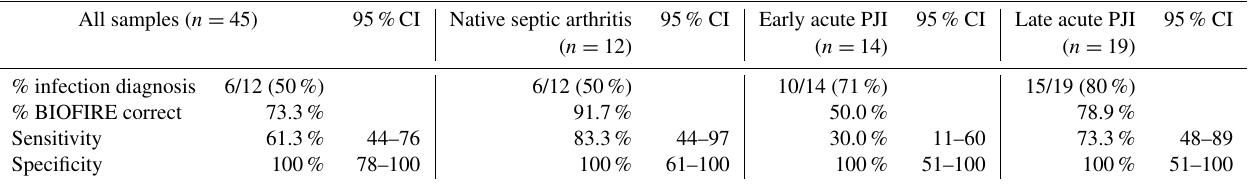
Table 3. Test accuracy of the BIOFIRE JI Panel for infection according to criteria and cultures (Methods section) as reference standard in patients with a clinical suspicion of native septic arthritis, early, or late acute PJIs. All samples ( n =